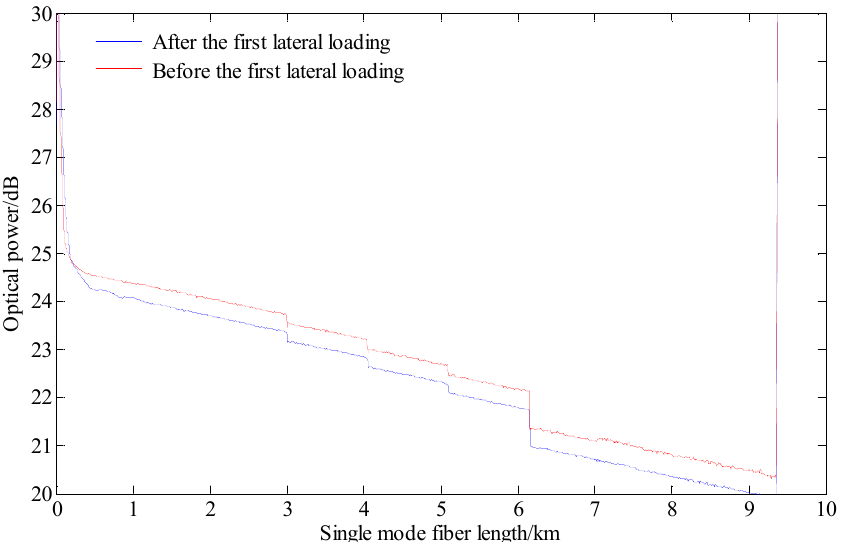
14 of 19 Figure 15. Measurement error mean square value and maximum measurement error of rod-fiber coupling structures I, II, Ш , and IV. 3.4. Analysis of Displacement-Region Identification Error In order to compare and analyze the change of optical loss of the rod-fiber coupling structure before and after lateral loading, the events and optical power distribution of the single-mode fiber line before and after the first lateral loading are shown in Figure 16. Before the first lateral loading, it could be observed that there were four events in the single-mode fiber line within the range of 2.5–6.5 km due to the initial optical loss of rod- fiber coupling structures. After the first lateral loading, the optical loss of rod-fiber